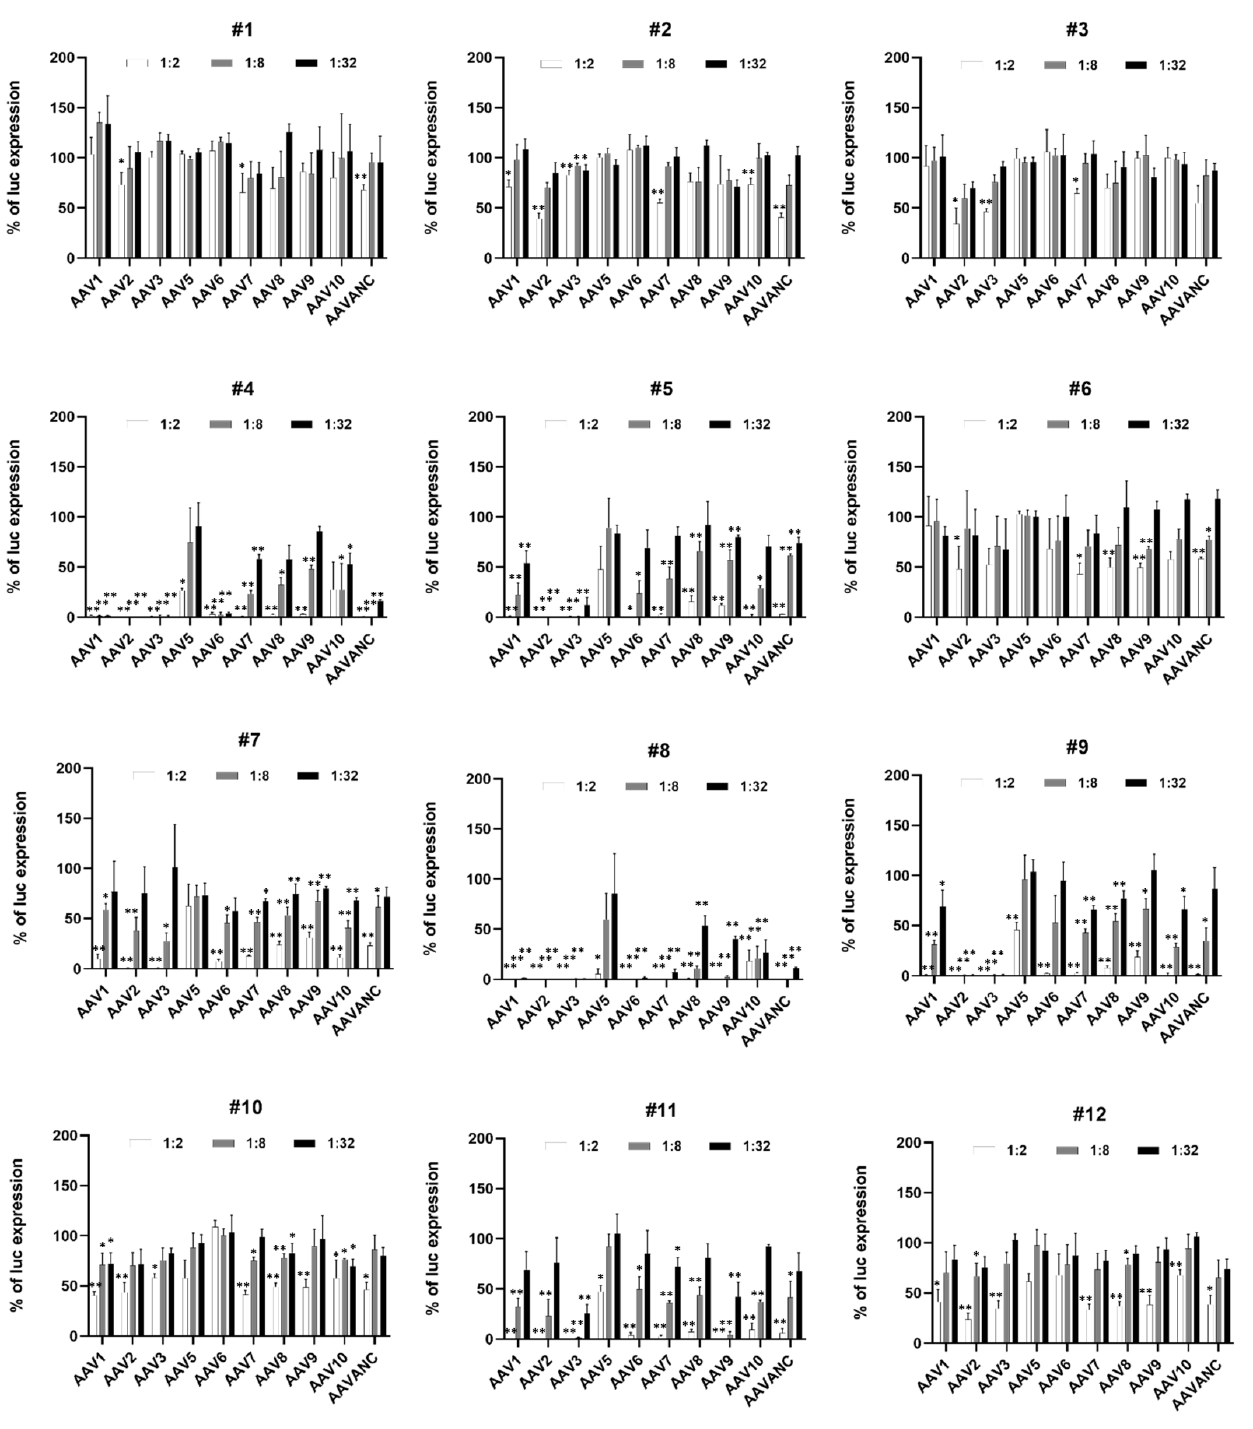
Figure 2. Screening of human samples for the presence of anti-AAV NAB. Human serum samples ( n = 12) were screened for the presence of NAB against 10 AAV serotypes. For the initial screening, tested serum samples were used at dilutions 1:2, 1:8, and 1:32, and FBS was used as a diluent. The data are presented as a percentage of luciferase activity in the presence of the corresponding dilution of tested samples compared to the control (AAV serotype X- Luc mixed with diluent only). Each column is a mean ± SD in triplicate. Statistically significant differences are indicated as p * < 0.05, p ** < 0.01 vs. the uninhibited control for each AAV serotype.